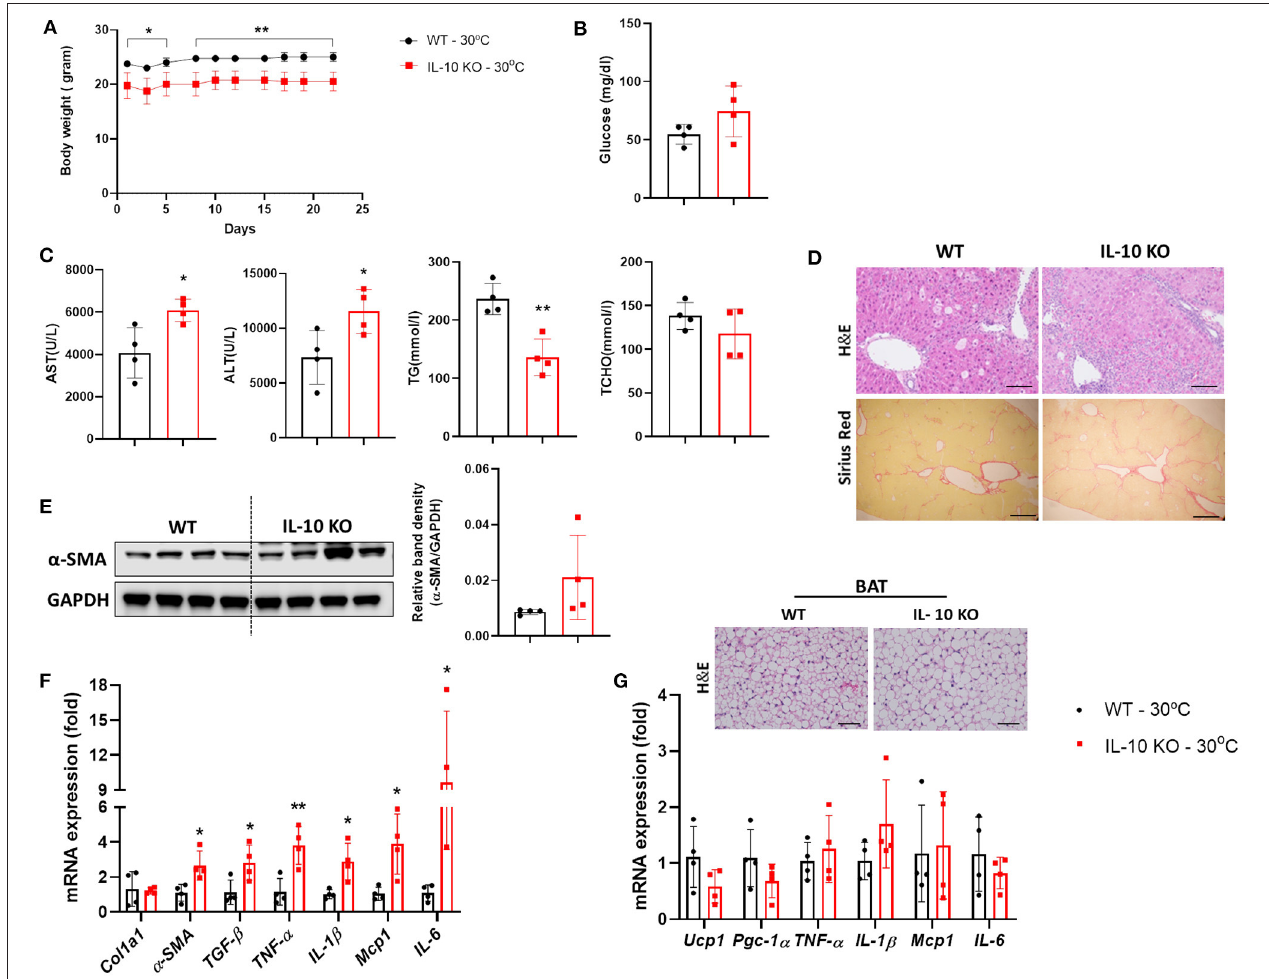
FIGURE 5 | IL-10-deficient mice displayed severe liver fibrosis under thermoneutral conditions. Mice with hepatic fibrosis induced by CCl 4 injection were housed under TN or standard conditions. (A) The body weight was determined before each injection. (B) The fasting blood glucose was measured at the time of sacrifice. (C) Serum AST, ALT, TG, and TCHO levels were assessed. (D) Whole liver tissues were used for western blotting to detect α -SMA. (E) Liver sections were stained with H&E (original magnification, × 20) and Sirius Red (original magnification, × 4). (F) Whole liver tissues were analyzed by real-time PCR. (G) Whole BAT tissues were subjected to real-time PCR for detecting inflammatory genes and BAT sections were stained with H&E (original magnification, × 10). Statistically significant differences were determined by Student’s t- tests. * p < 0.05, ** p <